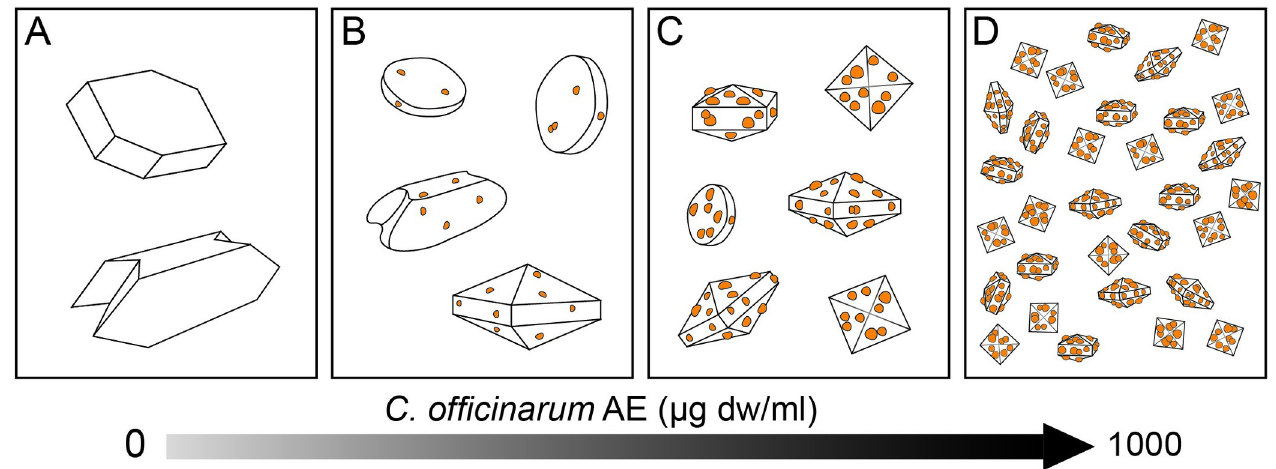
Fig 14. Schematic illustration of hypothetic model for morphological changes of CaOx crystals induced by increasing doses of C . officinarum AE. The diagram is indicative of the progressive adhesion of active components from C . officinurum on crystal surfaces as a hypothetic trigger factor directing the crystal modifications from COM towards COD forms. (A): Control; (B-D) progressively increasing doses of C . officinurum AE.